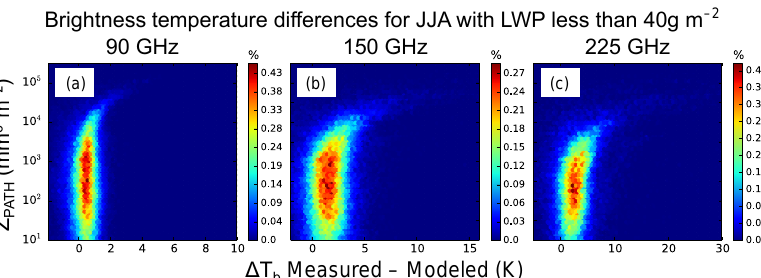
Figure 5. Brightness temperature differences between the MWRHF and the MWRHF-225 observations and the modeled gas and liquid contributions after implementing the LWP correction for ice for the 90, 150, and 225GHz channels. The count histogram is binned logarith- mically in Z PATH and linearly in (cid:49)T b , shown as percentage of total observation count per bin (same as Fig. 2). The high-frequency channels show a dependence of the difference in brightness temperature and the Z PATH from the MMCR – thus, indicating an increasing brightness temperature in these channels with increasing total ice amount in the column. Additionally, the sensitivity to the ice signature increases as a function of higher frequency. The Z PATH value where the ice signature BT enhancement begins is lower in the 150 versus the 90GHz channel ( b, c , respectively) and lowest in the 225GHz (c) . We note that there is a clear-sky bias in all three channels, but the magnitude of this bias is smaller than the radiometric uncertainty of the HFMWR observations. We are unable at this time to determine if this bias is due to calibration uncertainty in the radiometer or the result of forward model